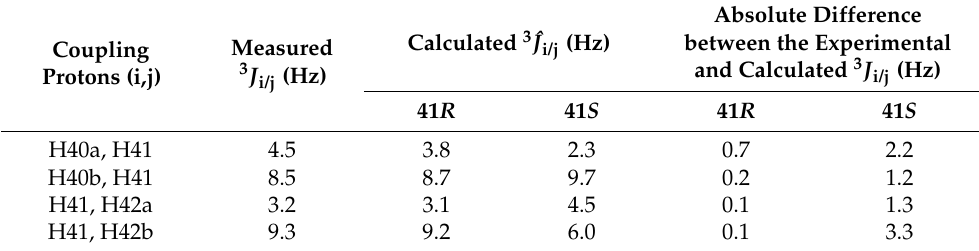
Table 1. Measured H40a/H41, H40b/H41, H41/H42a, and H41/H42b vicinal coupling constants compared to the theoretical values, calculated for 41 R and 41 S diastereoisomers of mepartricin